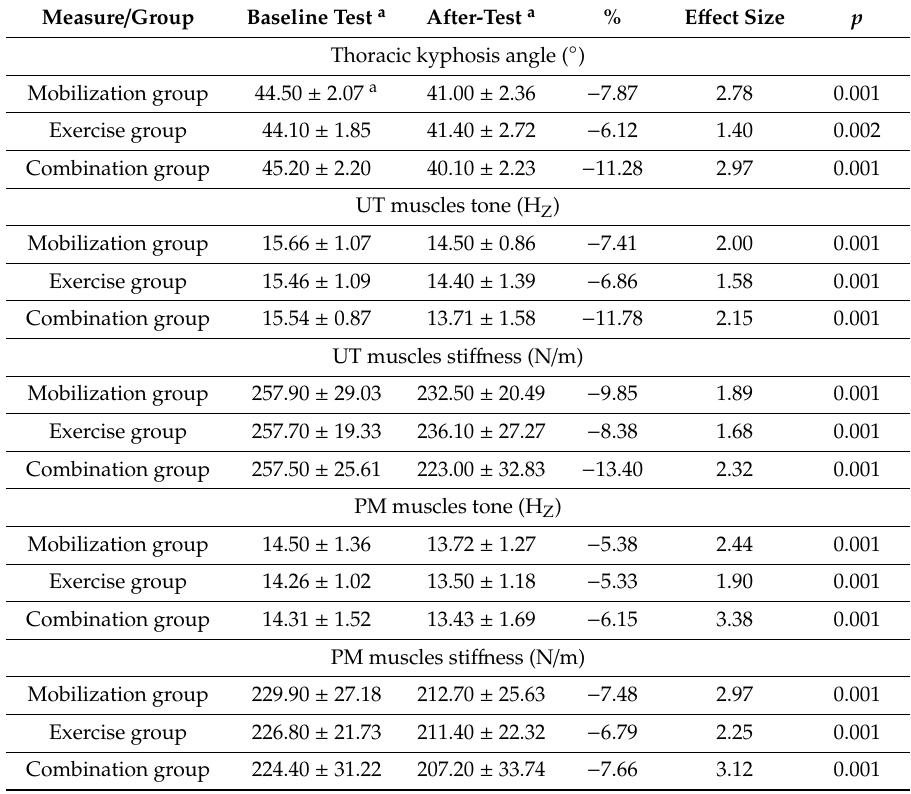
Table 2. Changes in the thoracic kyphosis angle, UT and PM muscles tone, and sti ff ness before and after intervention.